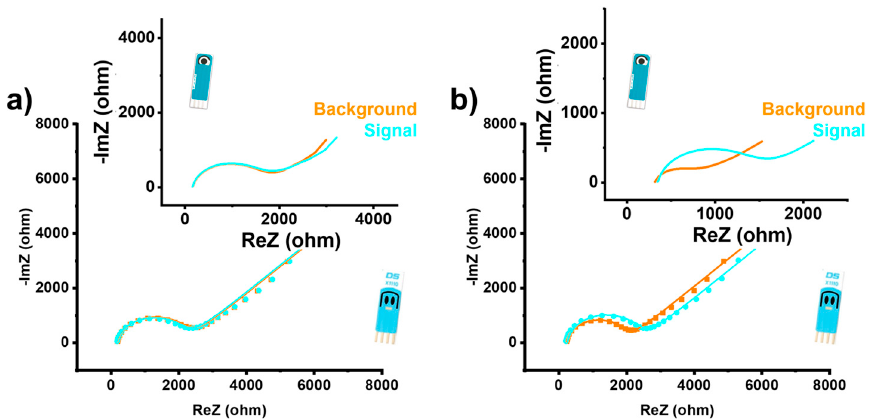
Figure 4. EIS (Nyquist plot) recorded at dual immunosensor for the negative ( a ) and positive ( b ) control, along with the corresponding measurements using conventional single SPCE.